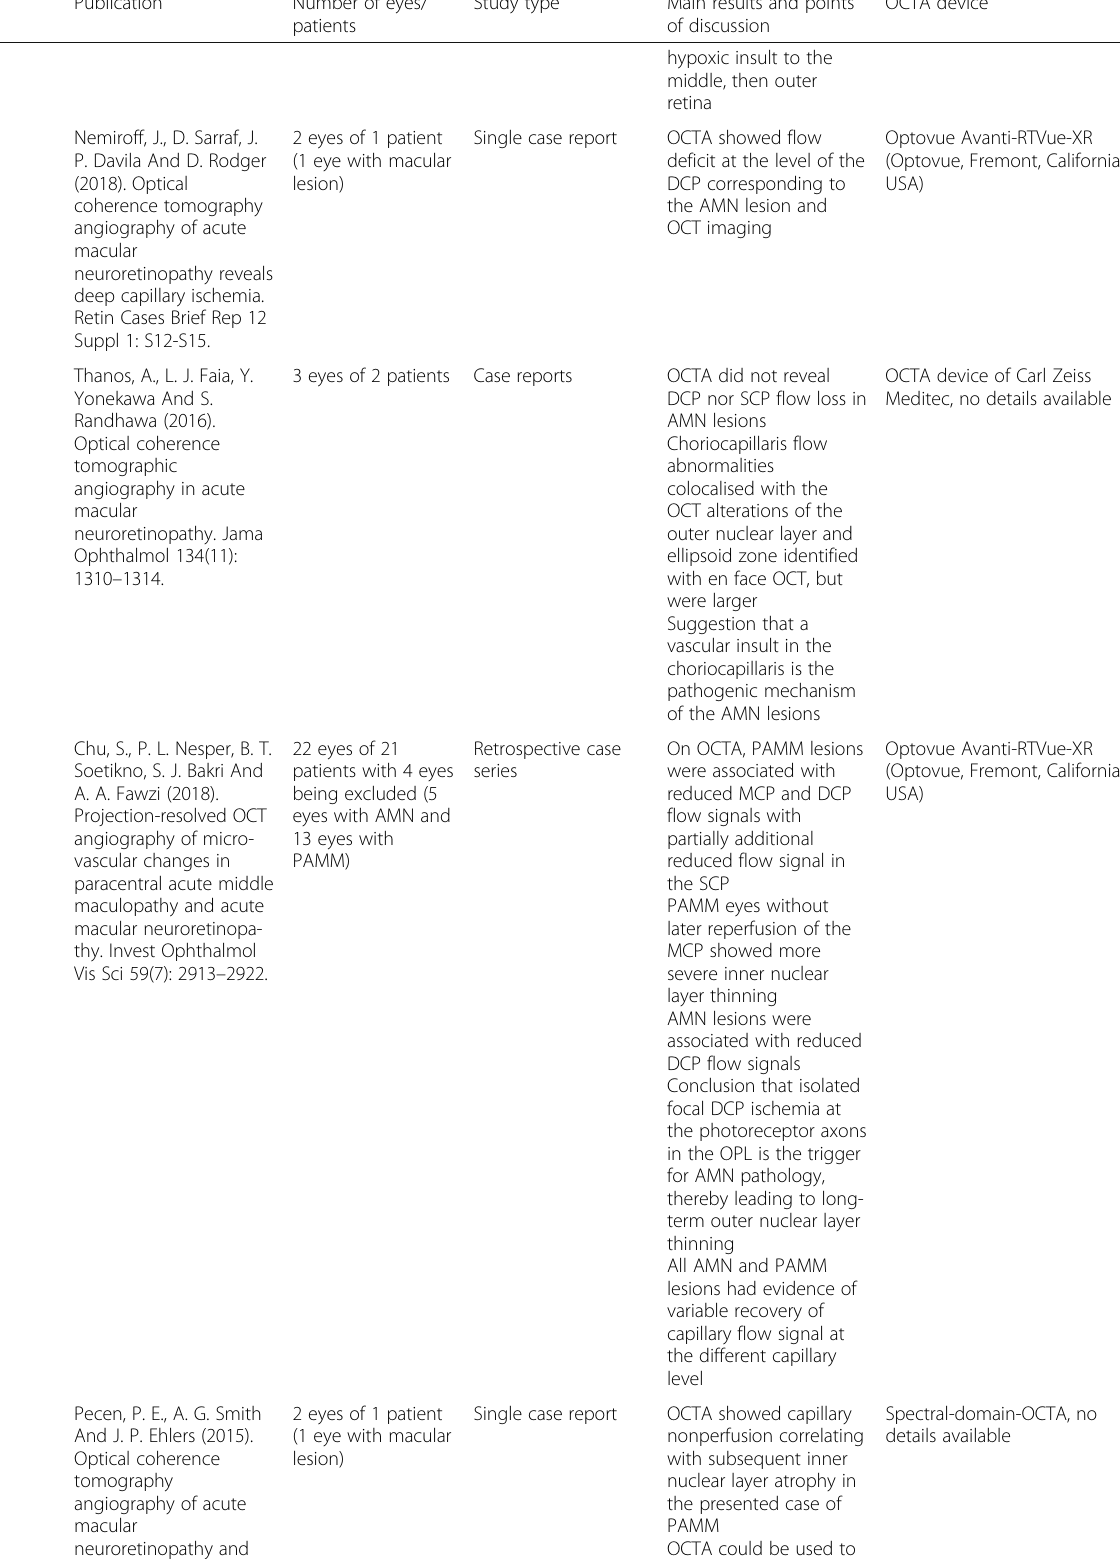
Table 1 Summary of publications on the implementation of OCTA in white dot syndromes (Continued)